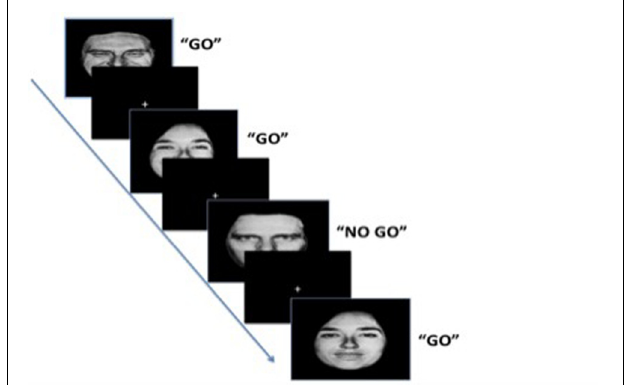
FIGURE 1 | Emotion Go/NoGo Task. The trials were 70% Go targets. Each stimulus was presented for 500 ms with an interstimulus interval of 1000